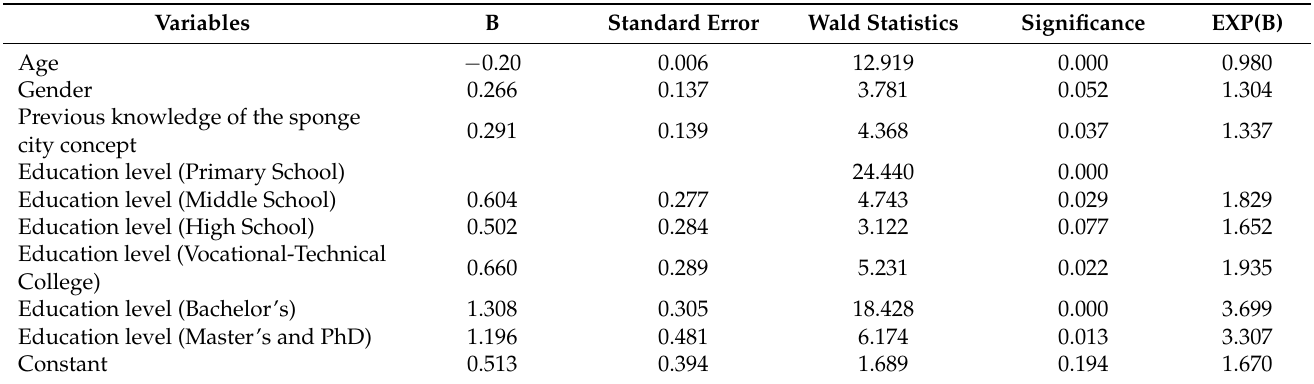
Table 2. Results of factors influencing respondents’